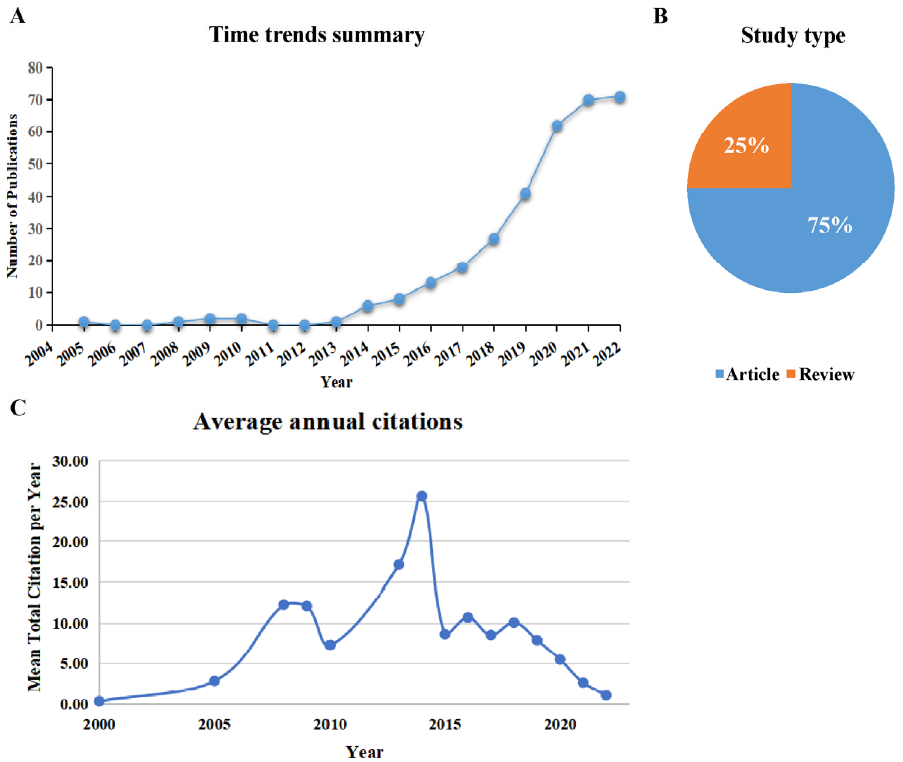
Figure 2. ( A ) Time trends summary. ( B ) Study type composition summary. ( C ) Summary of average annual citations.